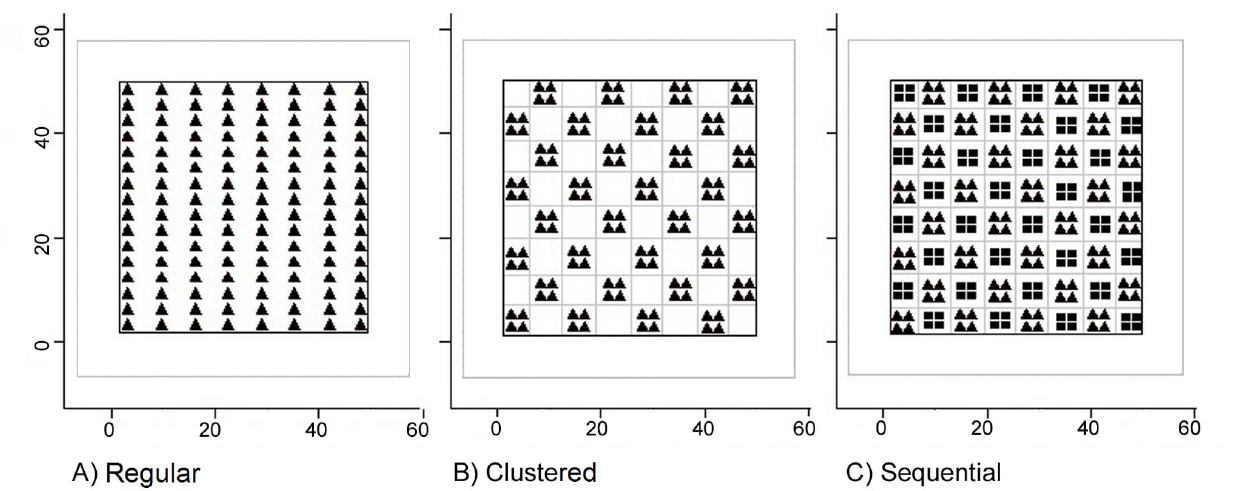
Figure 3. Three trap configurations: regular, clustered, and sequential. Three trap configurations were evaluated, shown with J=128 traps: (a) regular array, (b), clustered, and (c) a temporal sequence in which clustered traps of one arrangement (e.g. triangle) are moved halfway through the sampling period to new grids (e.g. squares). Gray gridlines in (b) and (c) overlay the non-overlapping grid sizes of an estimated female home range. The black outline around the traps depicts the 2,624 km 2 study area; the large gray square shows the extent of the 4,100 km 2 landscape.